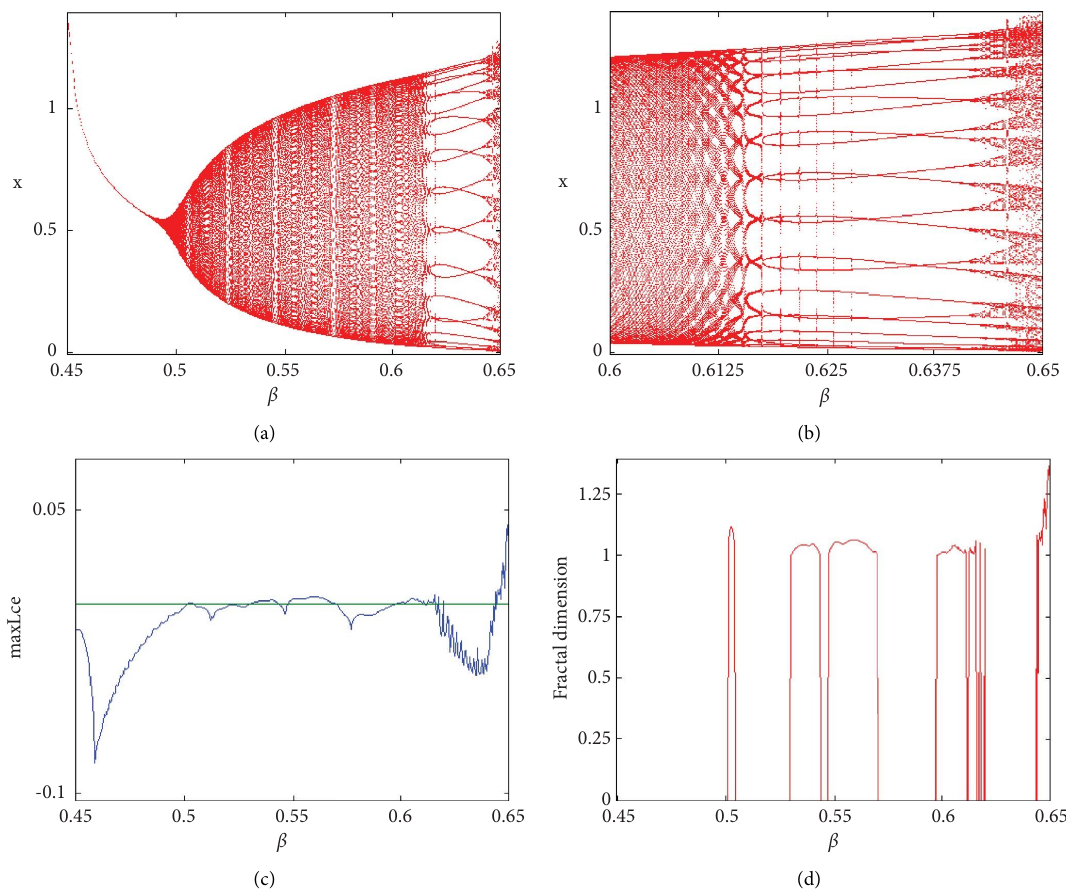
Figure 6: NS bifurcation diagrams of system (4) for β : (a) in prey, (b) local amplifcation in prey, (c) MLEs, and (d) FD ( x ( 0 . 2462 , 0 . 6793 )